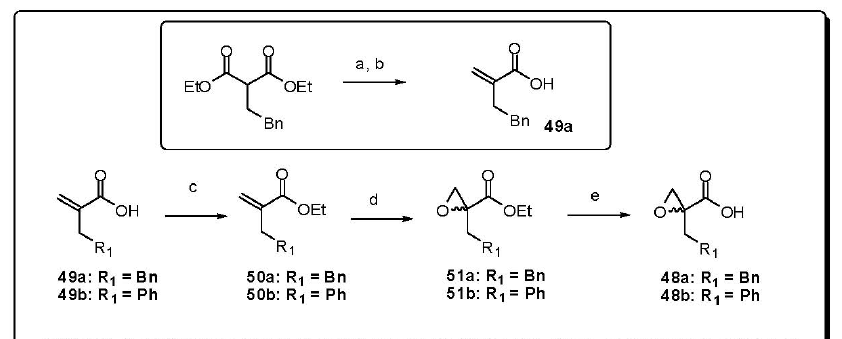
Figure 16. Synthesis of the P1